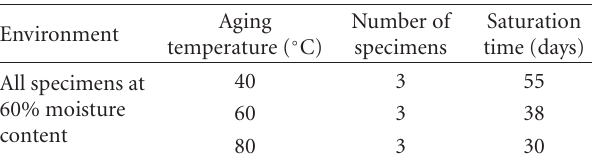
Table 1: The aging